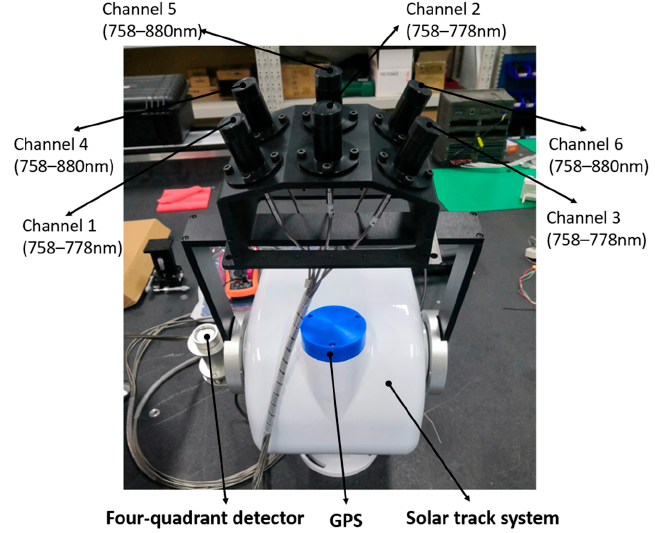
Figure 8. Several important parts of the sun tracking turntable and the installation relationship with the multi-angle front telescope.